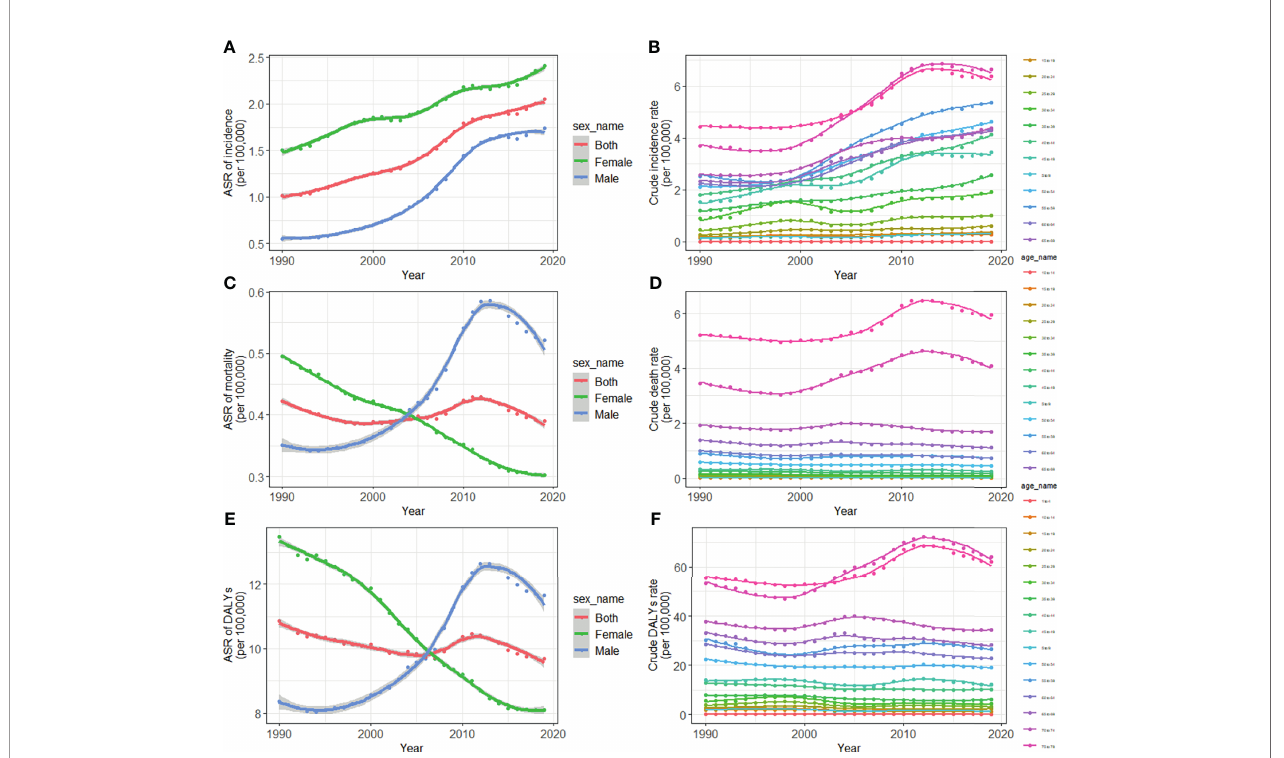
FIGURE 3 | Trends for ASIR (A) , age speci fi c incidence rate (B) , ASMR (C) , age speci fi c mortality rate (D) , age-standardized DALY rate (E) , and age speci fi c DALYs rate (F) of thyroid cancer in China from 1990 to 2019. ASIR, age-standardized incidence rate; ASMR, age-standardized mortality rate; DALYs, disability-adjusted